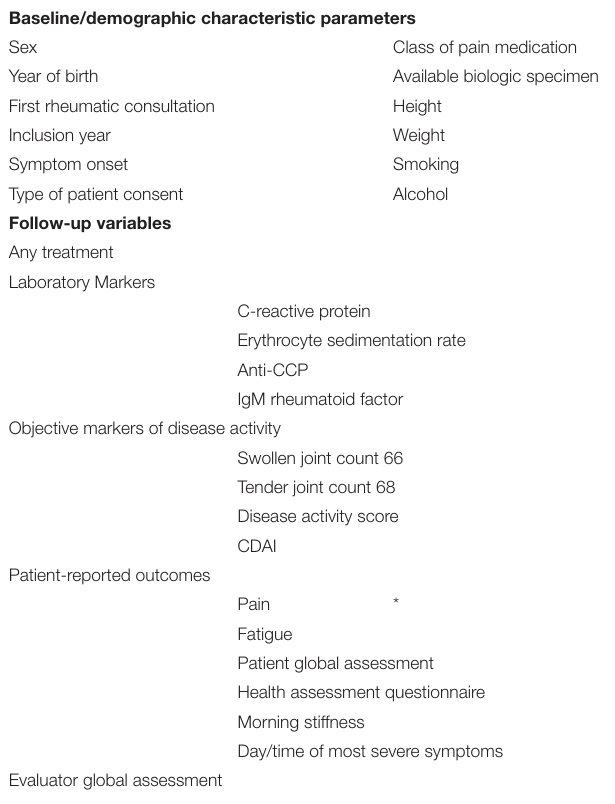
TABLE 1 | Agreed minimum core set to report in individuals at-risk